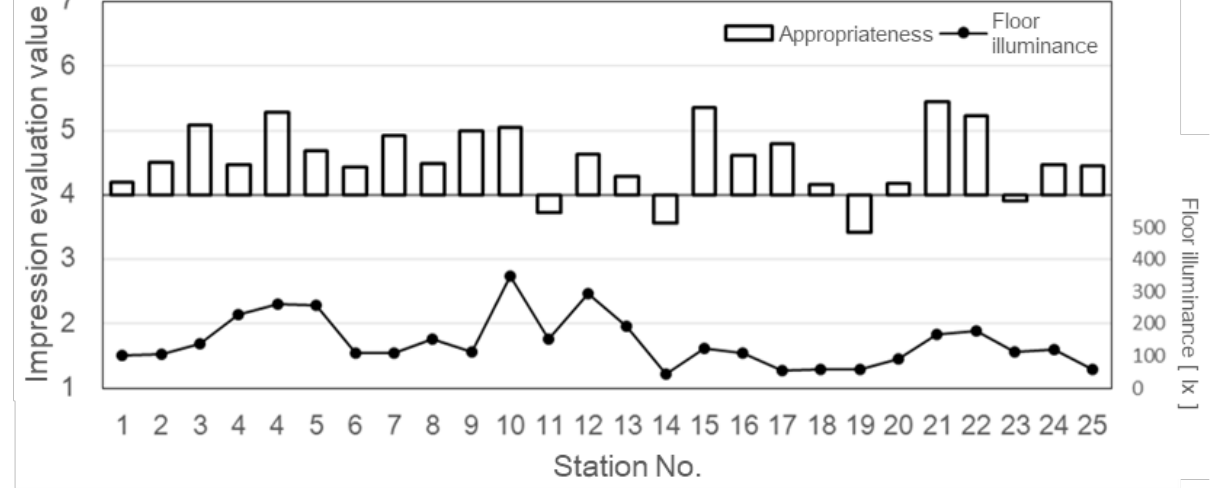
Figure 11. Results of the impression evaluation of appropriate lighting and floor illuminance.